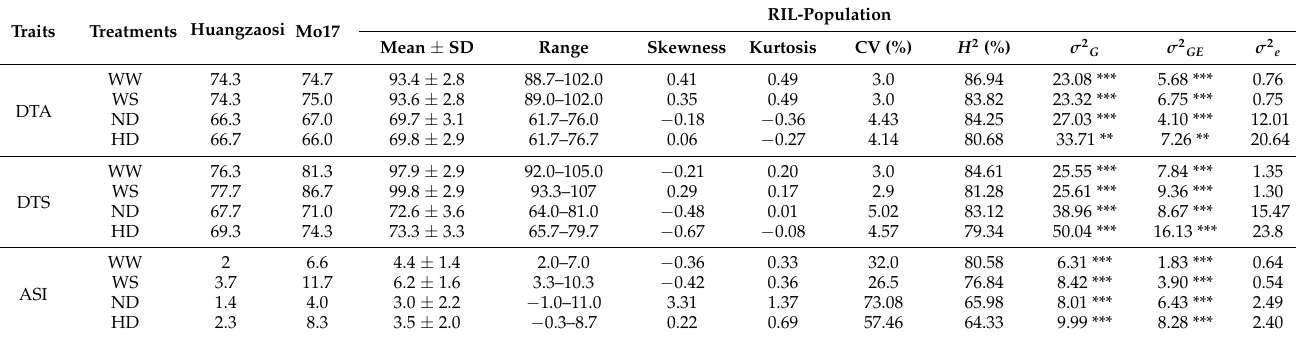
Table 1. Descriptive statistics, estimates of variance components, and heritability estimates for the flowering time traits of RIL population and its parental